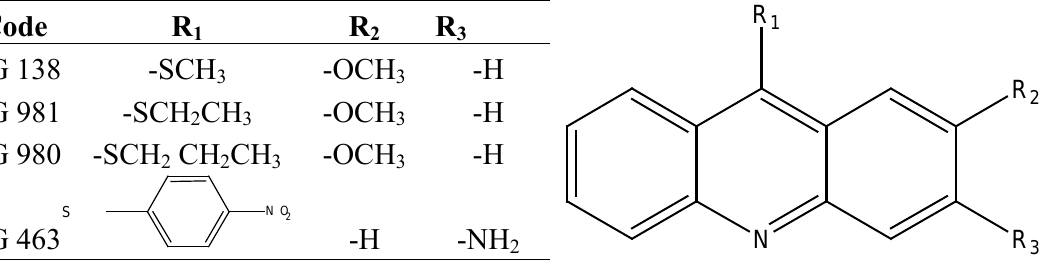
Fig. 1. The structures of the studied set of halobenzoic acids. X= F, Cl, Br, I. Table 1.- The structures of studied derivatives of